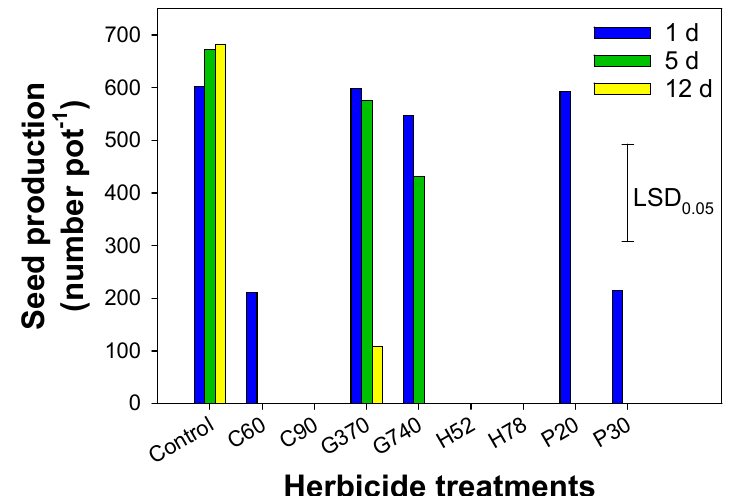
Figure 3. The interaction effect of herbicide (nontreated control; C60, clethodim 60 g a.i. ha − 1 ; C90, clethodim 90 g a.i. ha − 1 ; G370, glyphosate 370 g a.e. ha − 1 ; G740. Glyphosate 740 g a.e. ha − 1 ; H52, haloxyfop 52 g a.i. ha − 1 ; H78, haloxyfop 78 g a.i. ha − 1 ; P20, pinoxaden 20 g a.i. ha − 1 ; and P30, pinoxaden 30 g a.i. ha − 1 ) and their application timing (1, 5, and 12 d after grazing) on the seed production (number pot − 1 ) of Avena fatua .